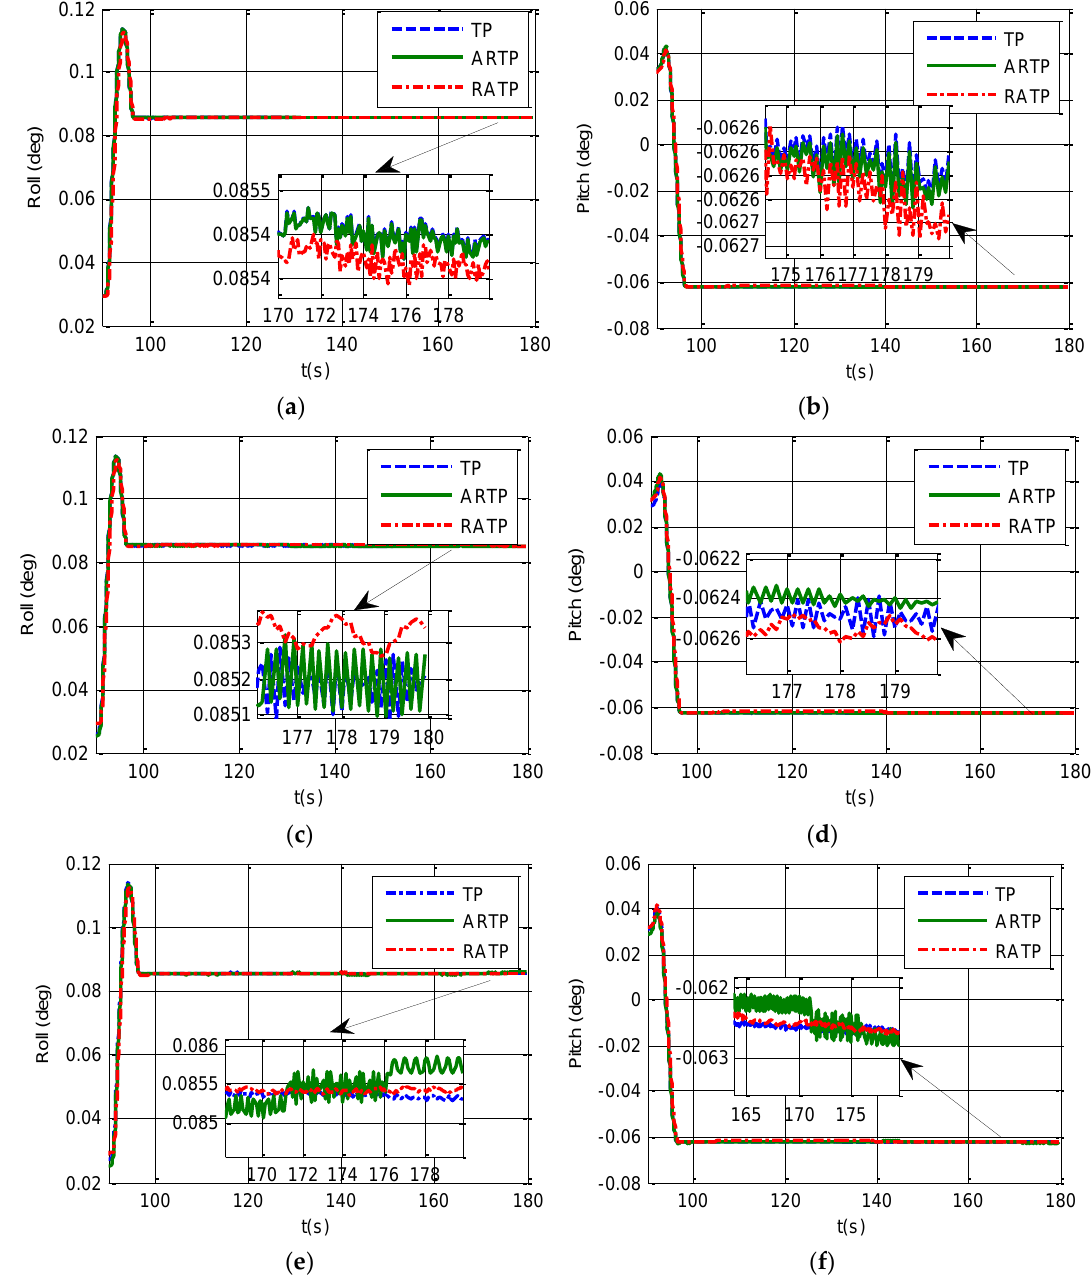
Figure 6. Horizontal curves under different conditions from 90 to 180 s. ( a ) Roll curve under stationary condition; ( b ) Pitch curve under stationary condition; ( c ) Roll curve under angular vibrations with an amplitude of about 5 arcsec and a random frequency between 5 and 10 Hz; ( d ) Pitch curve under angular vibrations with an amplitude of about 5 arcsec and a random frequency between 5 and 10 Hz; ( e ) Roll curve under angular vibrations with an amplitude of about 10 arcsec and a random frequency between 5 and 10 Hz; ( f ) Pitch curve under angular vibrations with an amplitude of about 10 arcsec and a random frequency between 5 and 10 Hz .